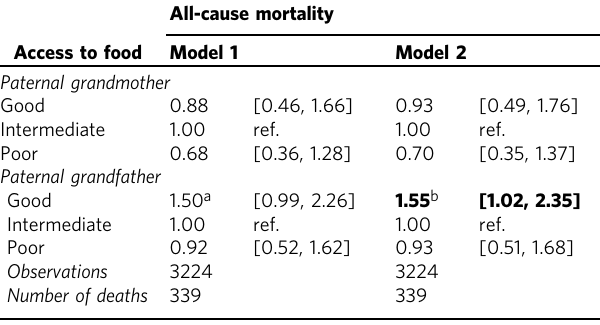
Table 1 All-cause mortality 1961 – 2015 in G2 men by paternal grandparents ’ harvest exposures in SGP: hazard ratios with 95% con fi dence limits (in brackets) based on Cox